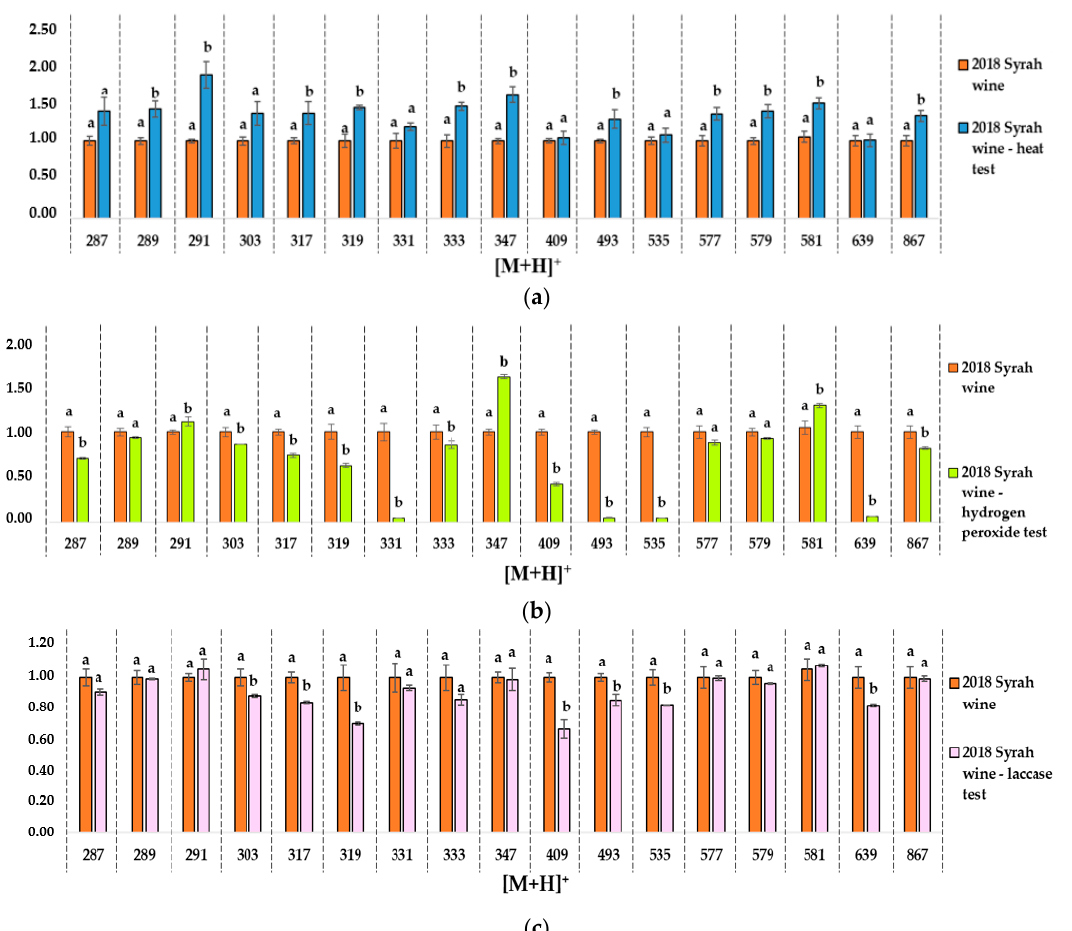
Figure 5. Ion intensity evolution in high resolution MS spectra. Intensity for the control wine aged 2018 and the ageing tests ( a ). Heat test –60 °C ( b ). Hydrogen peroxide test ( c ). Laccase tests . Results 2018 and the ageing tests ( a ). Heat test − 60 ◦ C ( b ). Hydrogen peroxide test ( c ). Laccase tests. Results are given for each [M+H] + ion compared to the 2018 sample. Intensities are expressed as mean values are given for each [M + H] + ion compared to the 2018 sample. Intensities are expressed as mean values with standard deviation. Different letters indicate a significant difference (Tukey test, α = 0.05) with standard deviation. Di ff erent letters indicate a significant di ff erence (Tukey test, α = 0.05) between between samples for the same [M+H] + ion. samples for the same [M + H] + ion. Data are available in supplementary data: Tables S20,